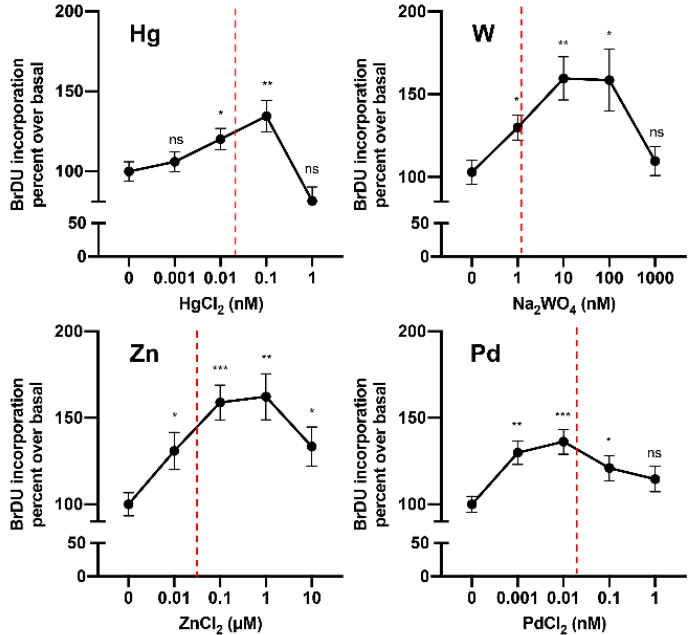
Figure 3. Metals at low concentrations stimulate human thyrosphere proliferation. Proliferation (measured by 5-bromo-2-deoxyuridine (BrDU) incorporation) of human thyrospheres (aggregates of thyroid stem / precursor cells) after chronic exposure to increasing concentrations of Hg, W, Zn, and Pd. Vertical dotted lines indicate the average concentration of each metal in the urine of residents in the volcanic area of Sicily [81].